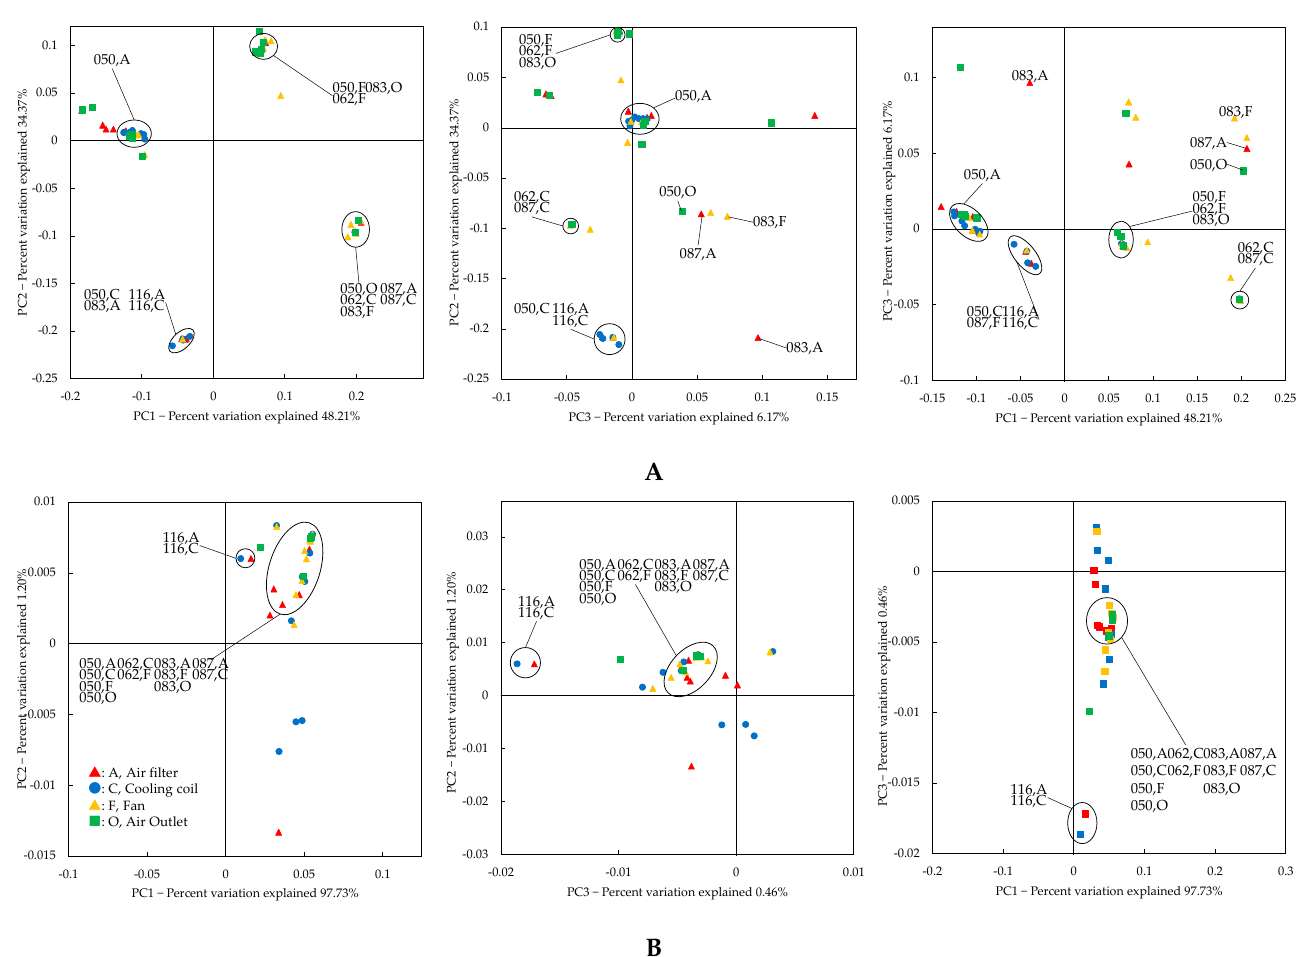
Figure 5. Principal coordinate analysis (PCoA) of partial expansion of the unweighted UniFrac distance ( A ) and weighted UniFrac distance ( B ). A, C, F, and O corresponded to air filter, cooling coil, fan, and air outlet.